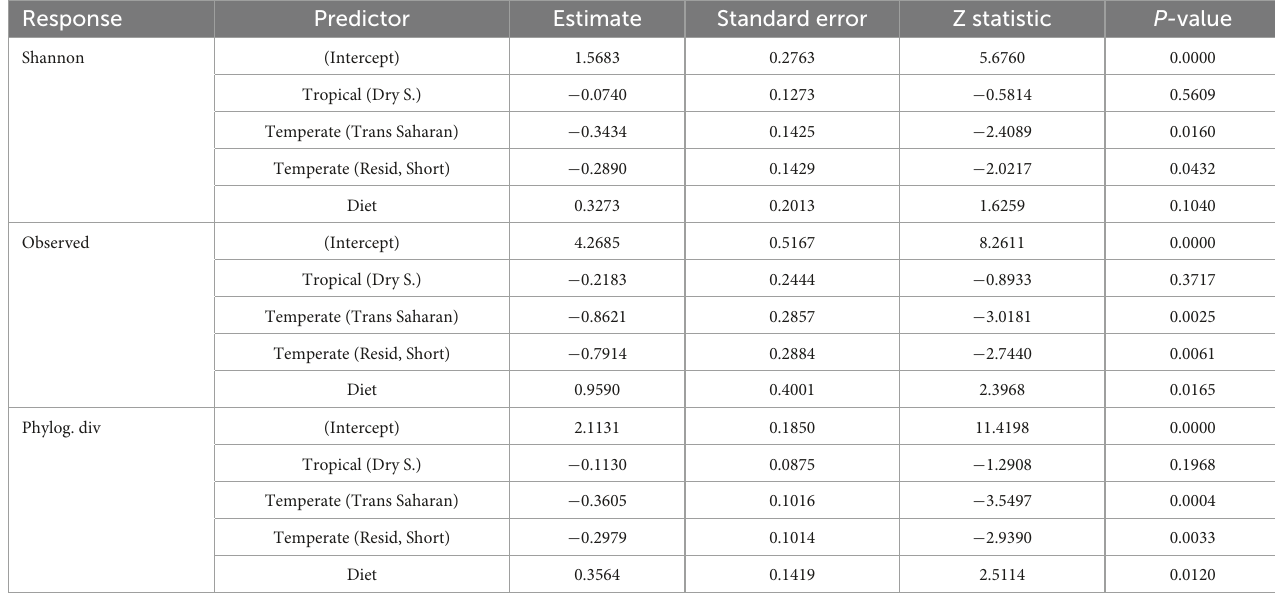
TABLE 1 Parameter estimates for mixed models analyzing the effect of climatic zones, season, migration, and diet on GM alpha diversity.